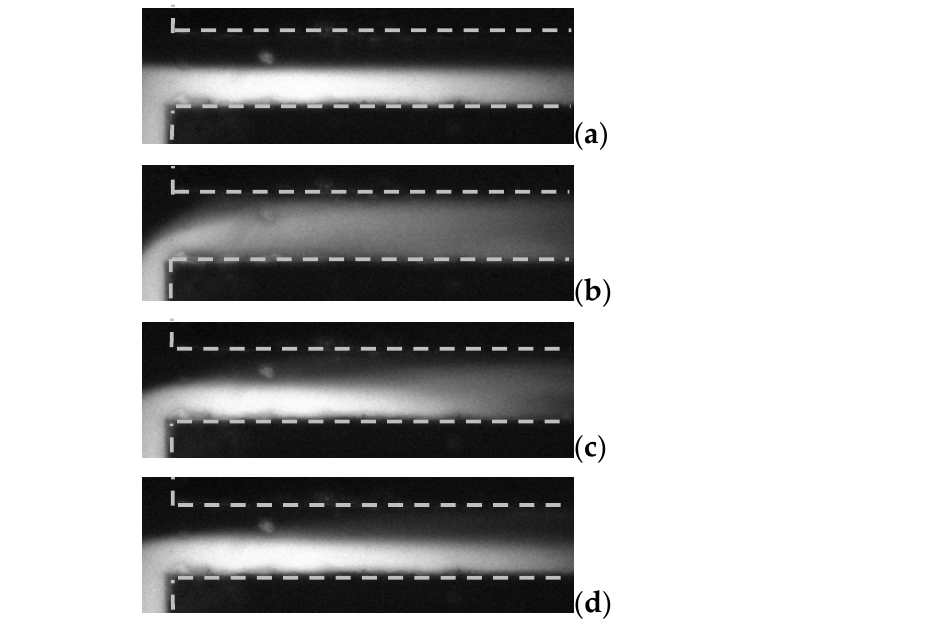
Figure 7. Visualization and comparison of mixing result in microchannels with different 𝑓 (cid:3002)(cid:3004) . Here, 𝛾 = 10 and 𝐸 (cid:3002) = 1667 V/cm. ( a ) No voltage, ( b ) 30 MHz, ( c ) 35 MHz, and ( d ) 40 MHz.